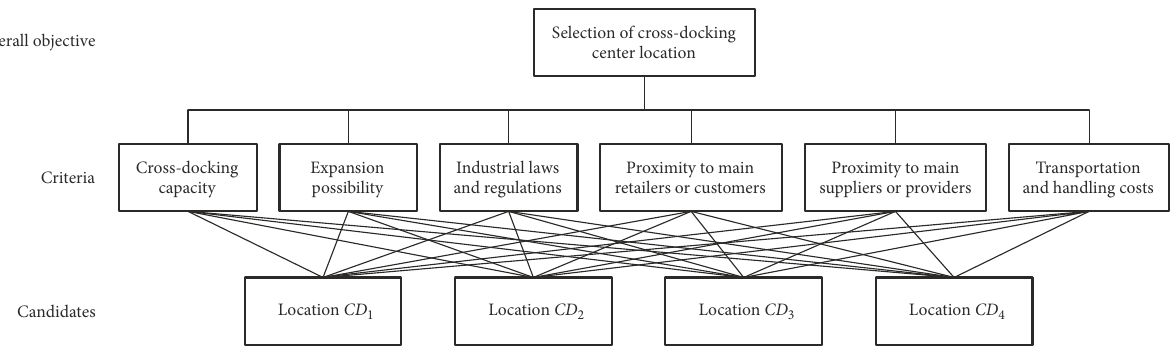
Figure 2. Hierarchical of the